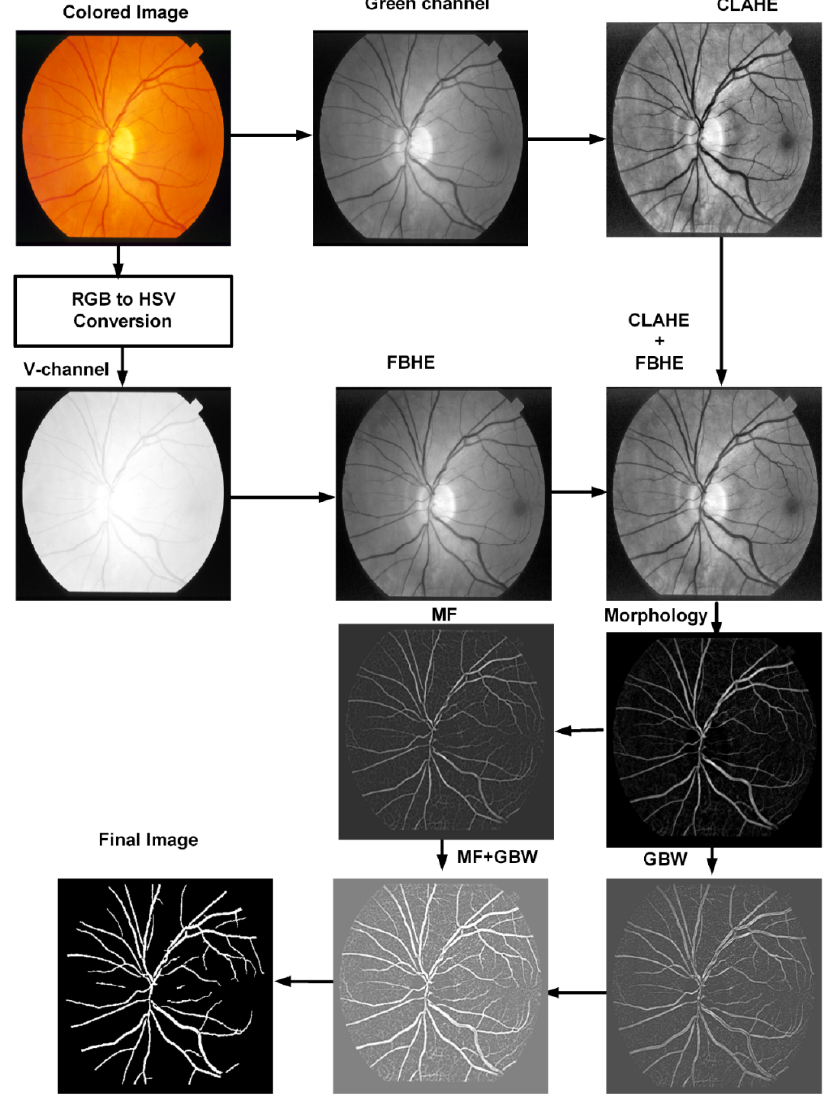
Figure 1. Block diagram of the suggested algorithm.